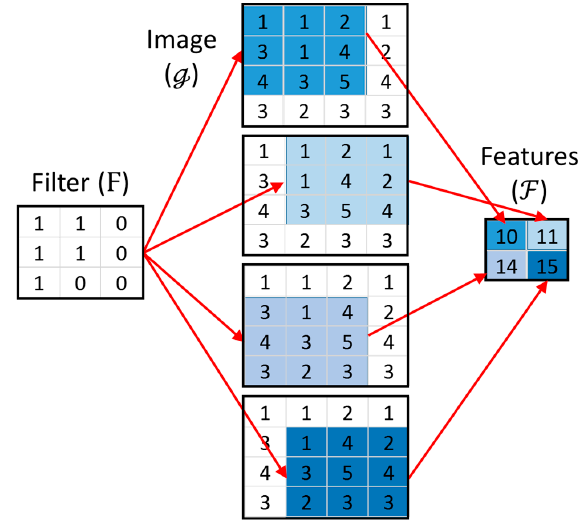
Figure 2. Convolution of a 4 × 4 image ( (cid:1325) ) with a 3 × 3 filter ( Ϝ ), yielding 4 features ( (cid:2272) ).